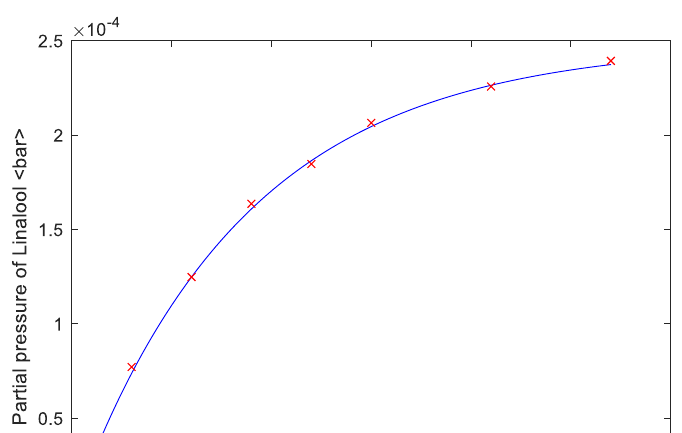
Figure 5. Modelling of Eucalyptol.